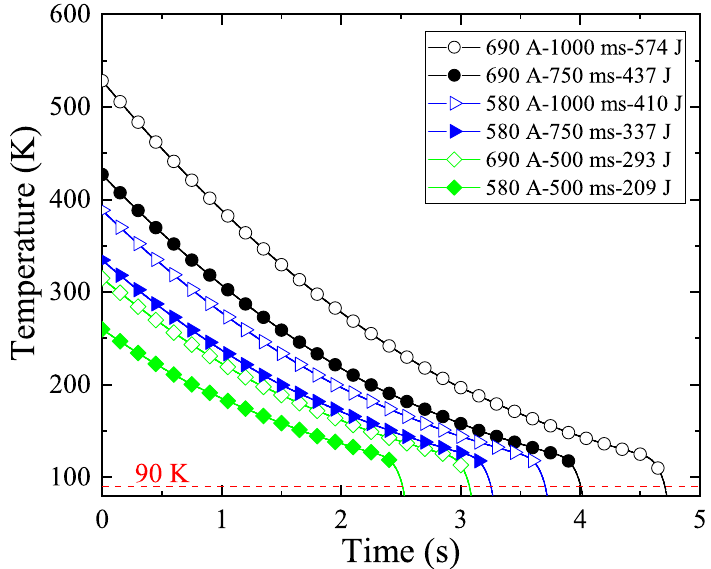
Figure 8. Curves of temperature asa function of time in the recovery process, calculated by the peak temperature. Different recovery processes are compared when the impact energy is 209 J, 293 J, 337 J, 410 J, 437 J and 574